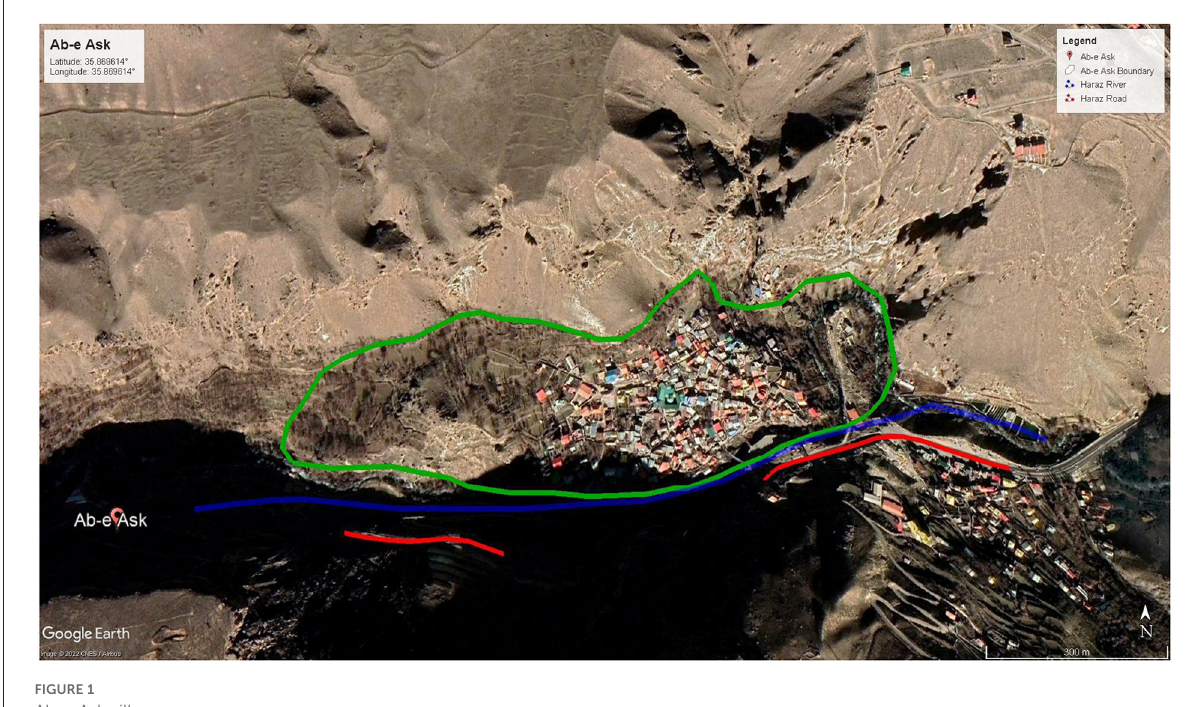
FIGURE1 Ab-e Ask village map.